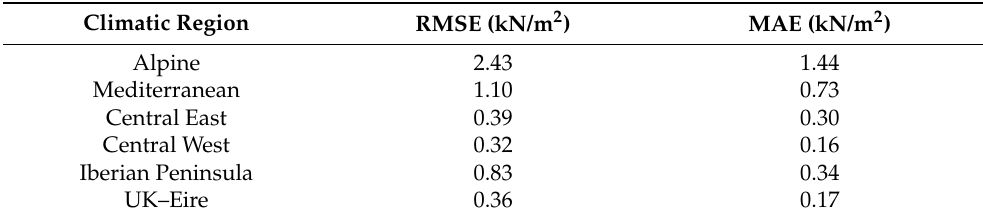
Table 2. RMSE and MAE statistics between RCMs ensemble mean and EN1991-1-3:2003 ground snow load map.